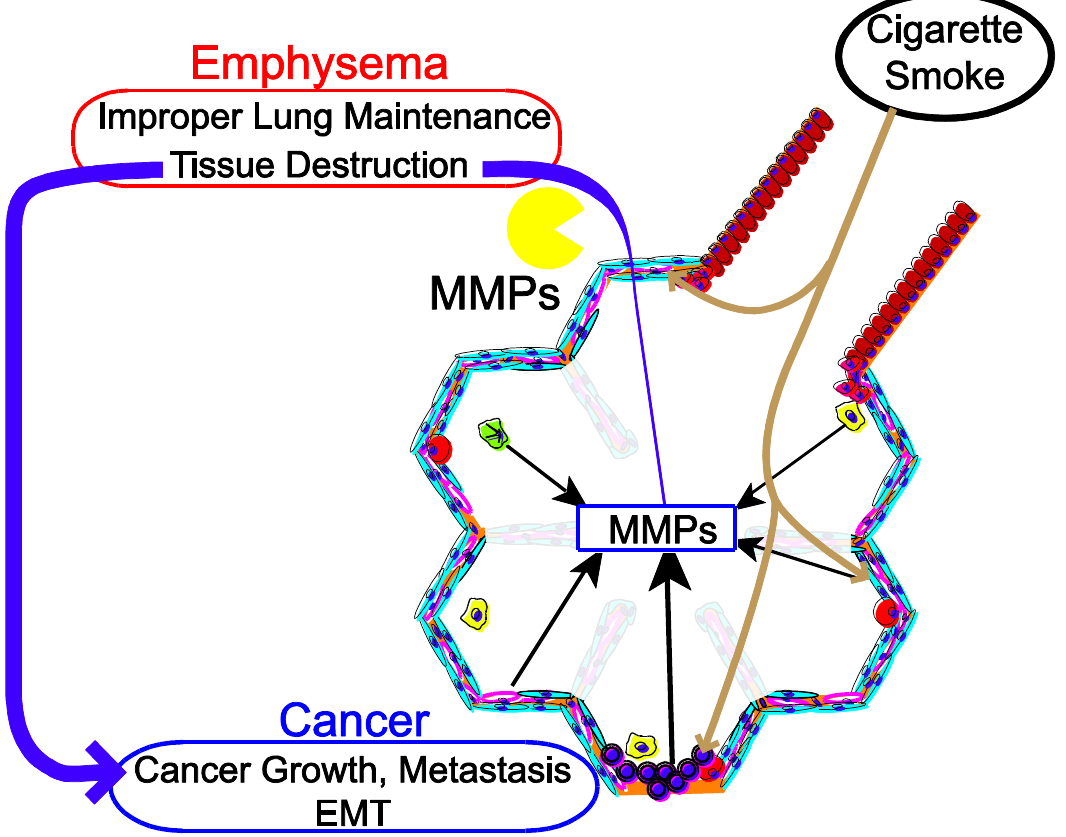
Figure 1. High MMPs microenvironment to promote and sustain emphysema and cancer